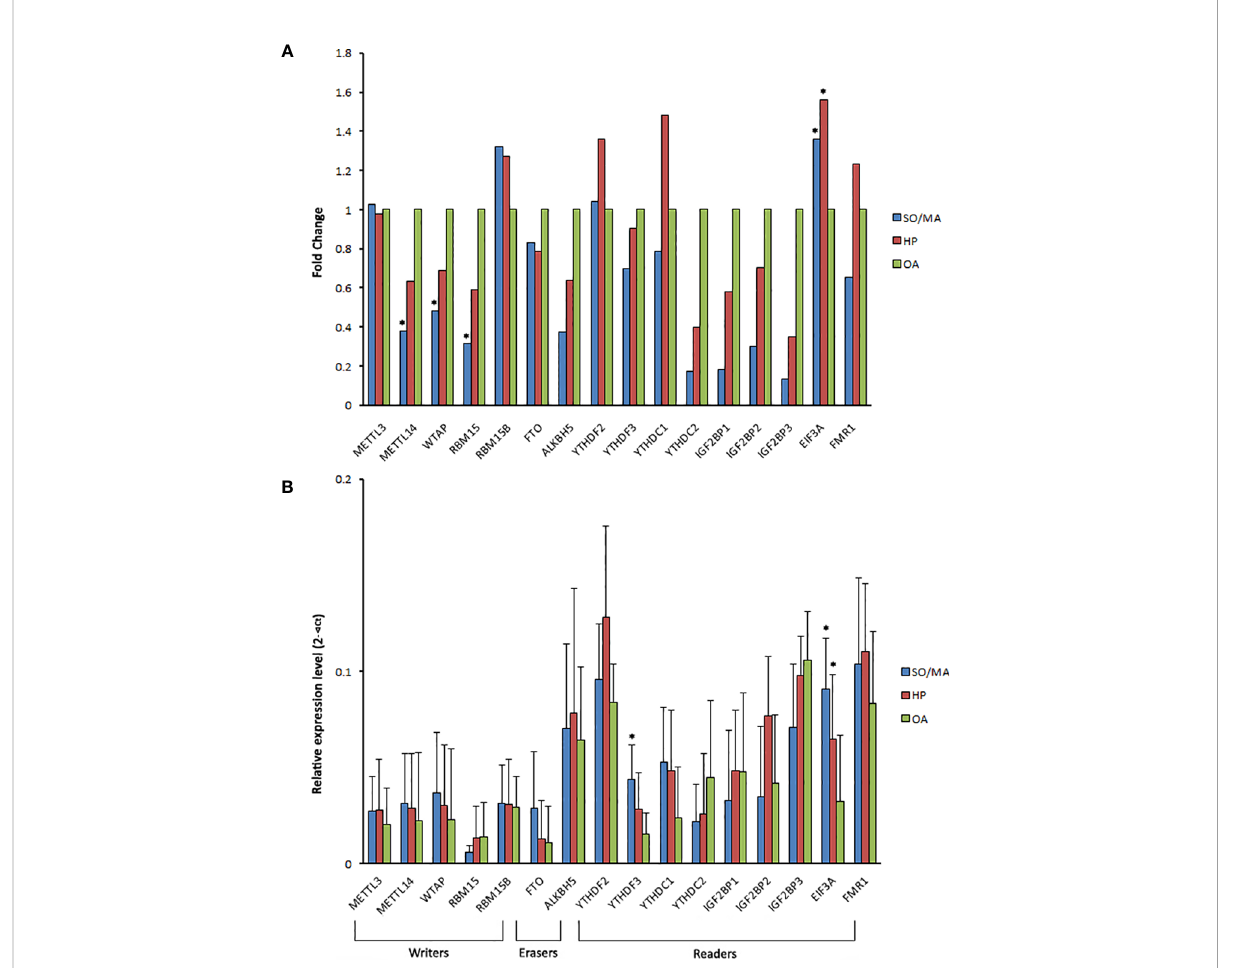
FIGURE 4 The gene expression of m 6 A related writers, erasers, and readers in the different groups. (A) The gene expression fold change of the m 6 A related writers, erasers, and readers in the SO/MA or HP group compared to the OA group via the detection of ArrayStar m 6 A microarrays. (B) The comparison of m 6 A related regulators ’ mRNA expression between the three groups using qRT-PCR. * P < 0.05 compared with the OA